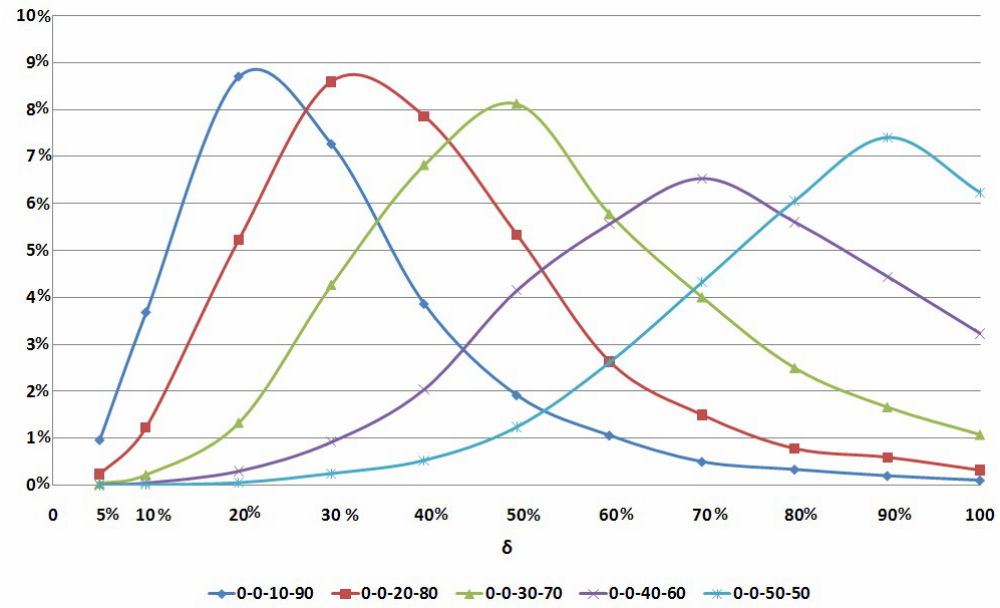
Figure 6. Average percentages of the instances whose optimality of the constructed pair of job permutations was proven at the on-line phase of scheduling.